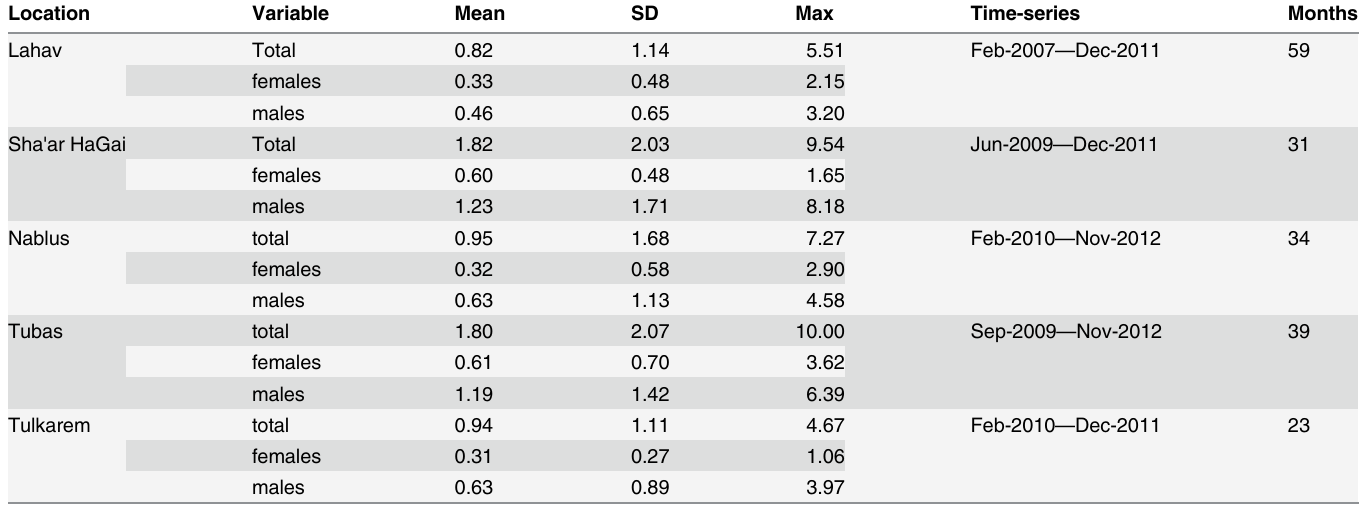
Table 1. Descriptive statistics for olive fly captures in the five locations in the Eastern Mediterranean region (see Fig 1). Location